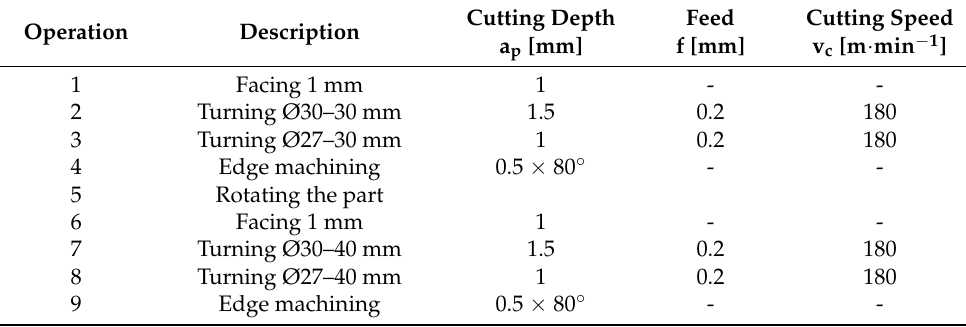
Table 4. Cutting parameters for machining of heat-treated